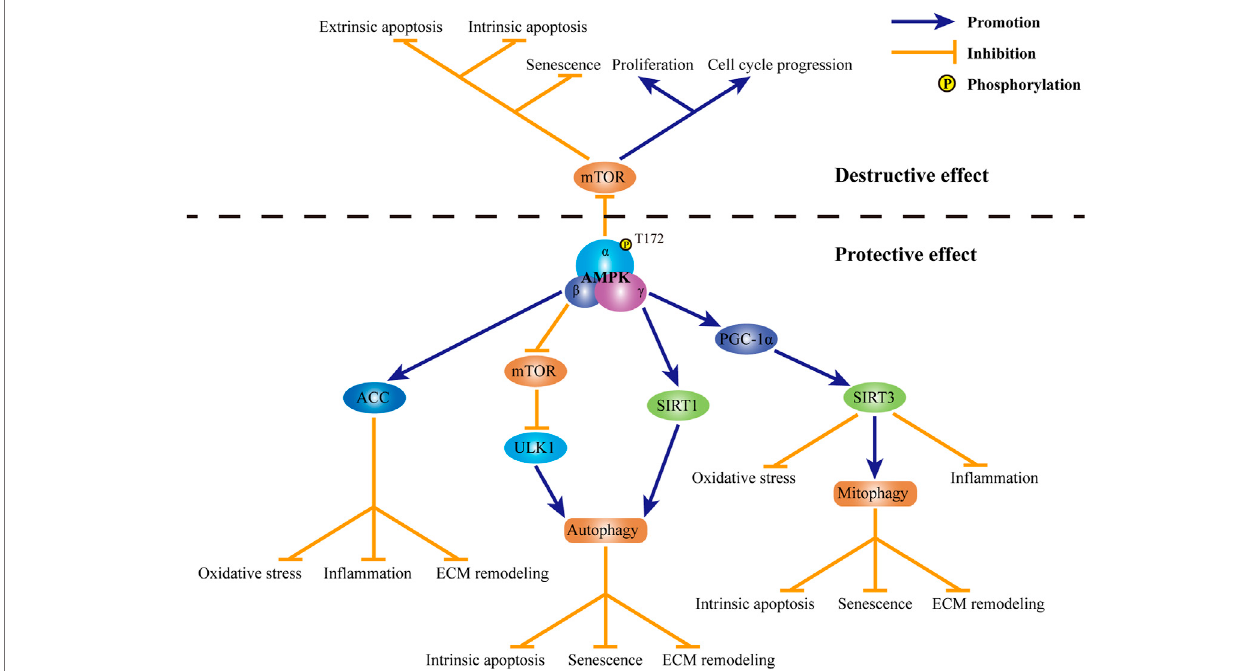
FIGURE 3 | Role of AMPK in IDD. Currently, both destructive effect and protective effect of AMPK in IDD have been observed. Through the inhibiting of mTOR, AMPK promotes cell apoptosis along with cell senescence, suppresses cell proliferation and retards cell cycle progression in IVD cells. In contrast, mechanism for the protection of AMPK in IDD is complicated. Through the activation of ACC, AMPK suppresses oxidative stress, in fl ammation and ECM destruction in IVD cells. By modulating mTOR-ULK1 pathway, AMPK induces autophagy in IVD cells. SIRT1 is also involved in AMPK-mediated autophagy in IVD cells. Through the induction of autophagy, AMPK suppresses intrinsic apoptosis, senescence and ECM remodeling in IVD cells. Through the activation of PGC-1 α and subsequent SIRT3, AMPK promotes mitophagy and inhibits oxidative stress and in fl ammation in IVD cells. By maintaining mitochondrial homeostasis, AMPK may protect IVD cells against intrinsic apoptosis,senescenceandECMdestruction.AMPK:AMP-activatedprotein kinase;IDD:intervertebraldiscdegeneration;mTOR:mammaliantargetofrapamycin;IVD: intervertebral disc; ACC: acetyl-CoA carboxylase; ECM: extracellular matrix; ULK1: UNC-51-like kinase 1; SIRT1: sirtuin1; PGC-1 α : peroxisome proliferator-activated receptor γ coactivator 1 α ; SIRT3: sirtuin